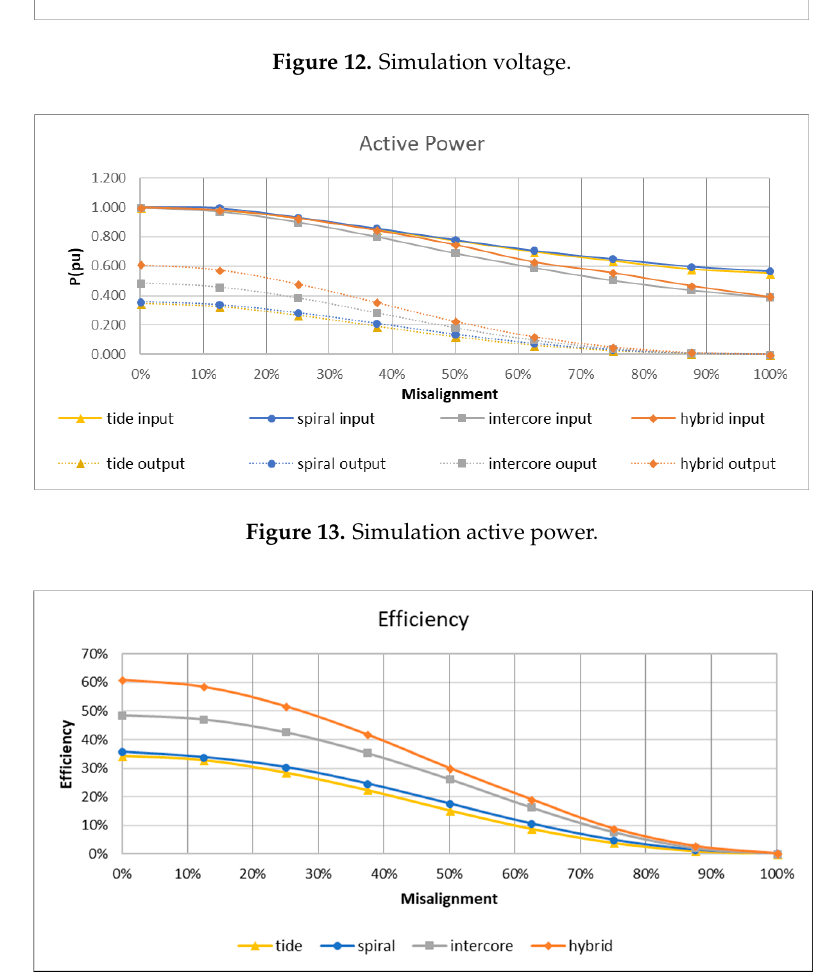
Figure 14. Simulation efficiency.